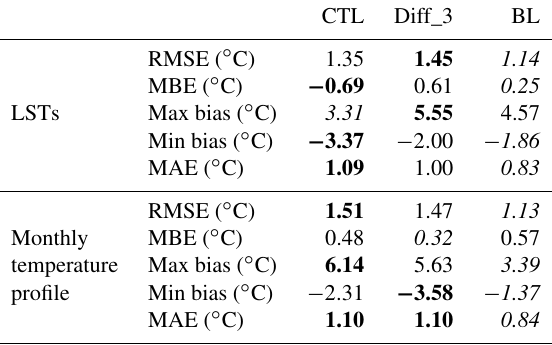
Table 4. Statistics of the discrepancy between simulated (CTL, Diff_3, and BL) and observed LSTs and monthly temperature pro- files during year 2015. Root-mean-square error (RMSE) and Mean Absolute Error (MAE) are calculated between each simulation and measurement. Mean bias error (MBE), max bias, and min bias are computed by simulation minus measurement. Bold and italic font indicate the largest and smallest absolute values among three simu- lations,